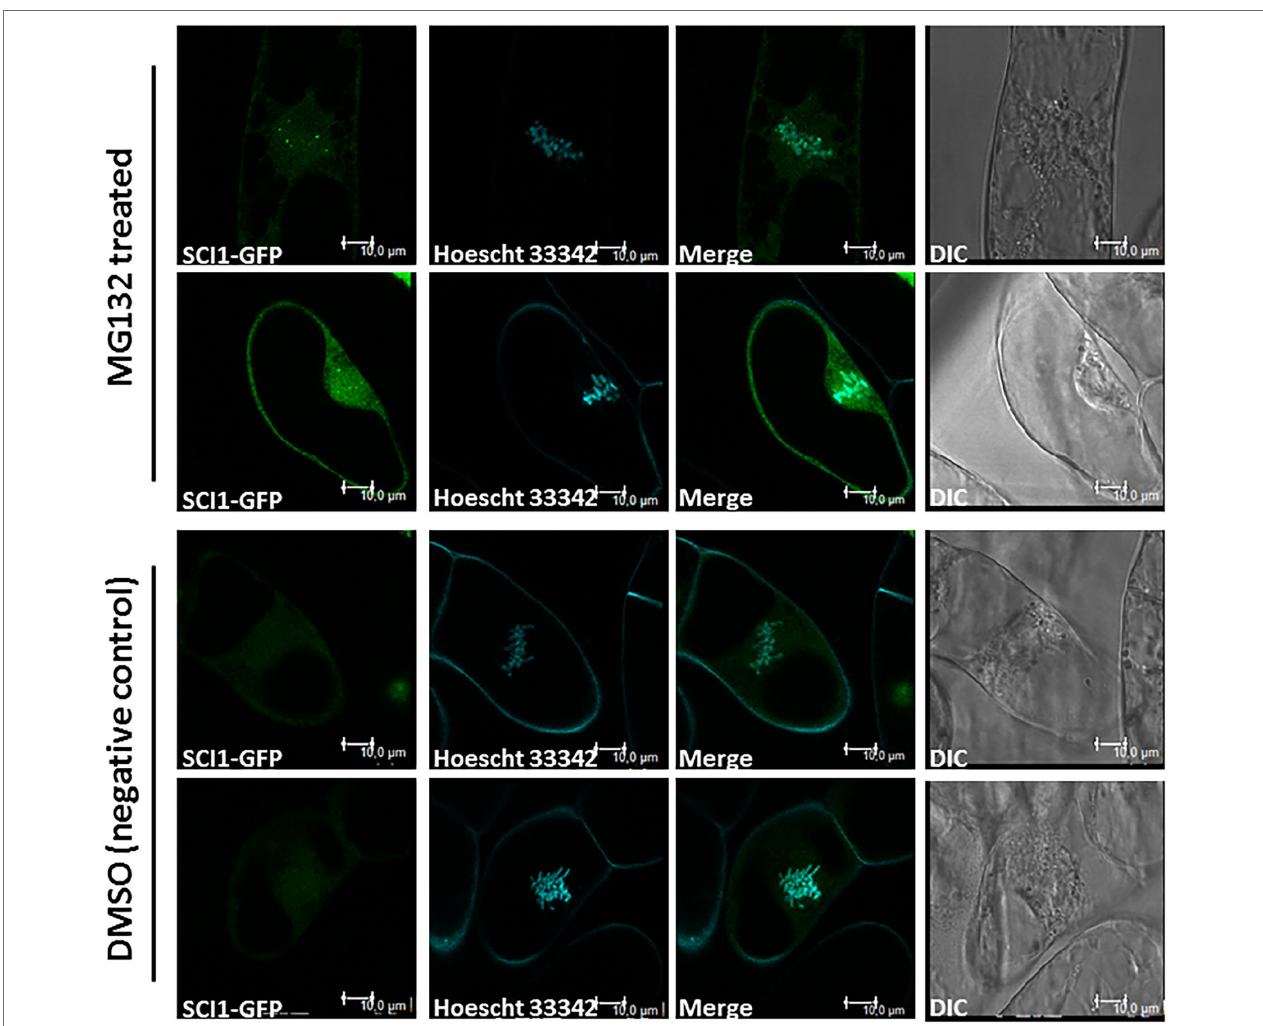
FIGURE 5 | Stigma/Style Cell-Cycle Inhibitor 1 is stabilized upon treatment with MG132, an inhibitor of 26S proteasome. Confocal microscopy images showing SCI1-GFP in metaphase cells after treatment with MG132 (50 μ M in DMSO) and control (DMSO). Tobacco BY-2 cells stably transformed with 35S prom ::SCI1-GFP were stained with Hoechst 33342. Images were captured using Leica TCS SP5 (Leica Microsystems). DIC—Differential interference contrast microscopy. Scale bars—10 μ